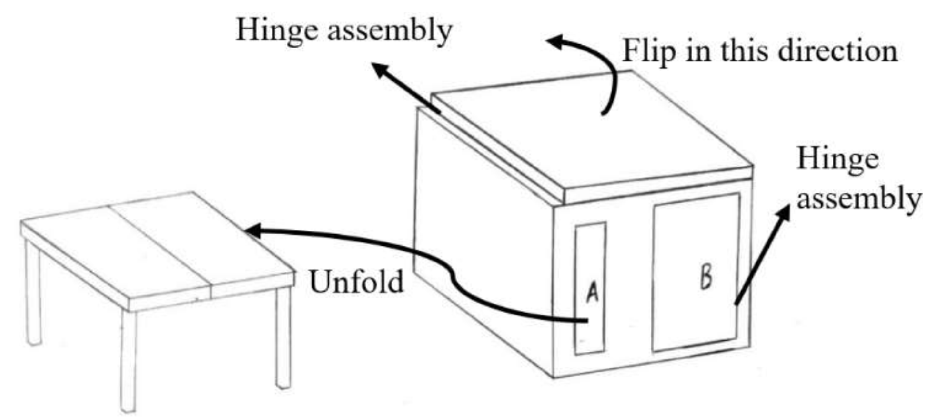
Figure 2. Hand sketch of concept 1.